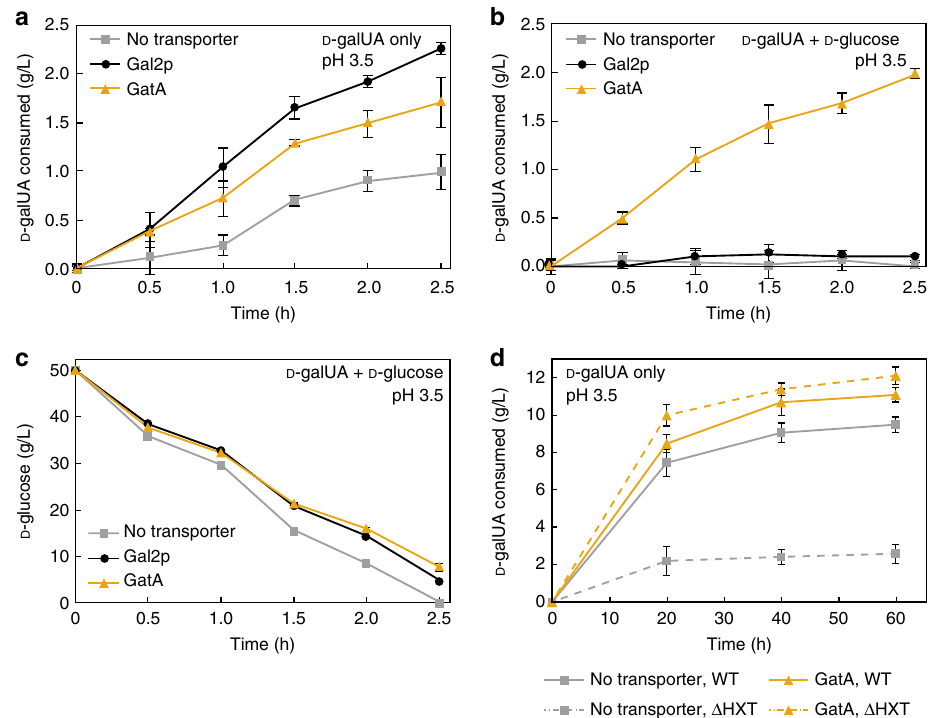
Fig. 3 Expression of GatA enables co-consumption of D -glucose and D -galUA. D -galUA utilization strains expressing no transporter (yRJP064), Gal2p (yRJP054) or GatA (yRJP093) were incubated in pH 3.5 media containing 20g/L D -galUA ( a ) as the sole carbon source or b , c D -galUA and D -glucose at high density (OD 600 = 75). d Hexose transporters are necessary for consumption of D -galUA at low pH and GatA rescues consumption of a hexose knockout strain. Wild-type and hexose knockout (HXT1-7, GAL2) D -galUA utilization strains expressing no transporter (yRJP193, yRJP195) or GatA (yRJP194, yRJP196) were incubated in pH 3.5 media containing 20g/L D -galUA (OD 600 = 10). Error bars represent standard deviation of biological